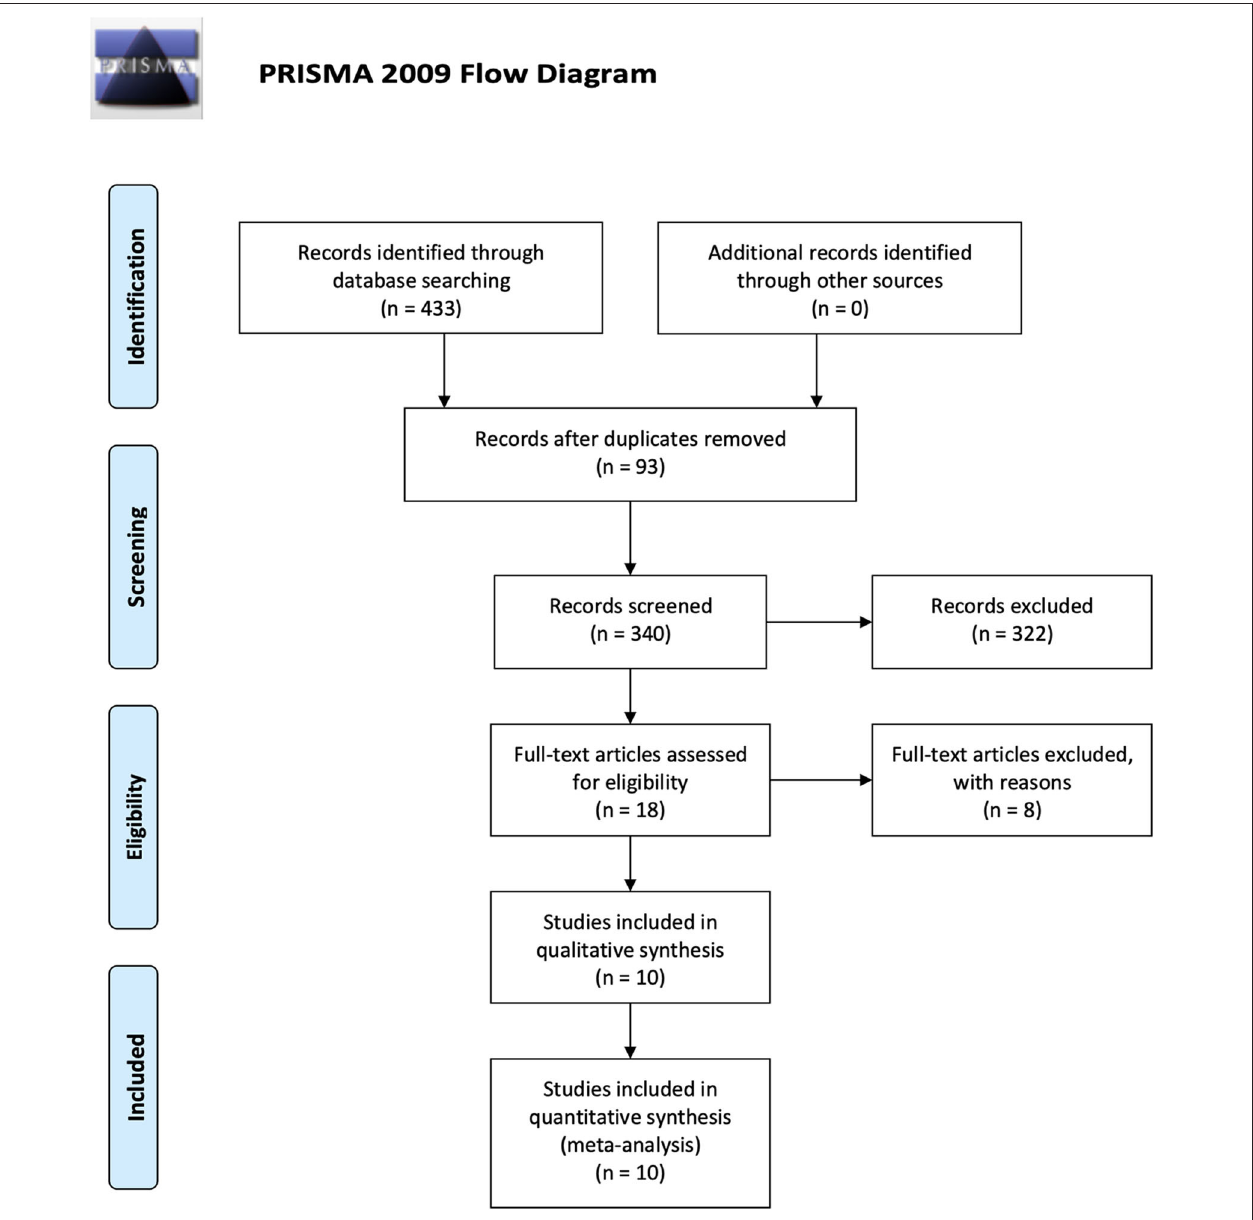
FIGURE 1 | Flowchart presenting the results of the literature search and the strategy used to select studies that relate to the crosstalk between MSCs and M ϕ s of musculoskeletal diseases. Study selection process. The search revealed 433 records. A total of 93 overlaps were removed between the databases. The remaining 340 records were screened by title and abstract, and 322 records were excluded. The remaining 18 studies were examined using their full texts, and finally ten eligible studies were identified.